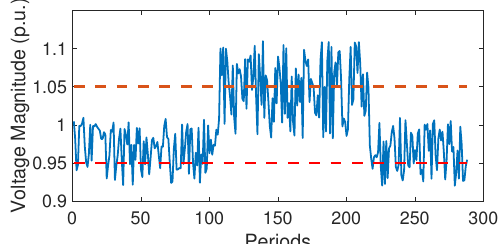
Figure 3. The blue line shows the variation of the magnitude of voltage where there is no control mechanism. The red lines show the acceptable limits.